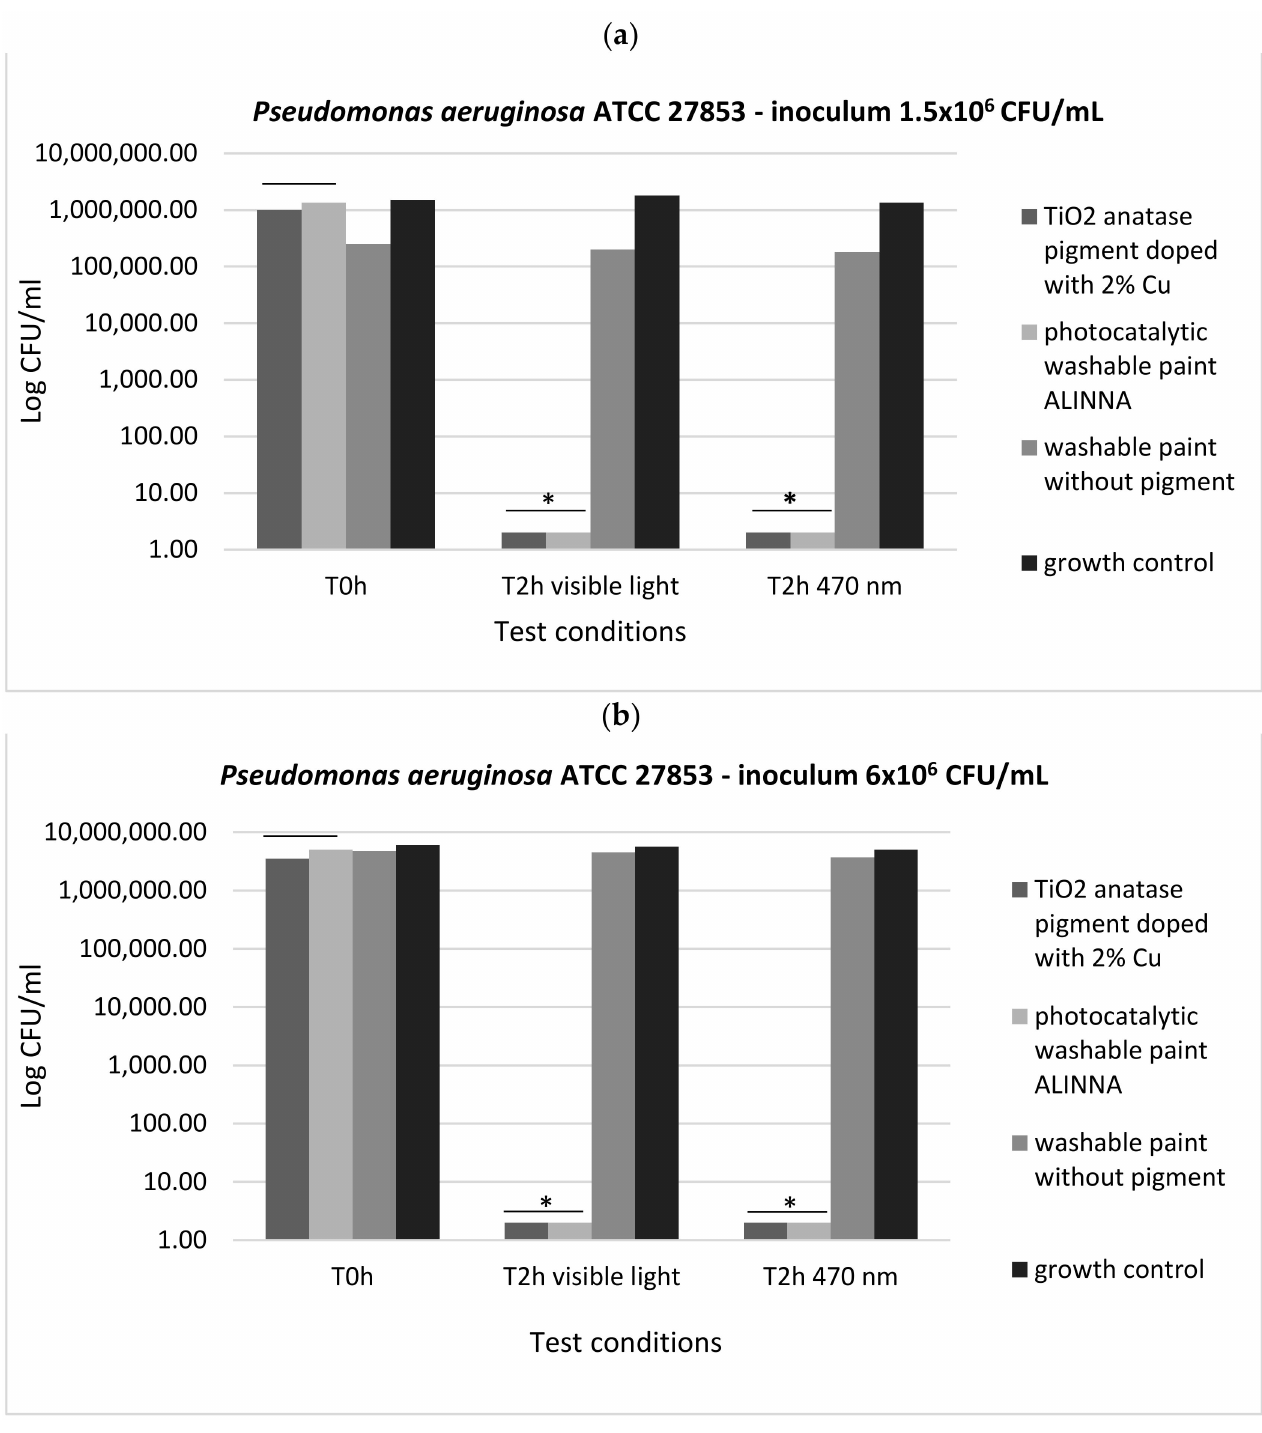
Figure 18. Graphical representation of the log10 values of colony-forming units (CFU)/mL representing the viable cells of P. aeruginosa ATCC 27853 after the 2 h contact with tested products, in two conditions: blue light (470 nm) and visible light; ( a ) 1.5 × 10 6 CFU/mL tested bacterial cell density; ( b ) 6 × 10 6 CFU/mL tested bacterial cell density; * 0.05 ≥ p (T ≤ t) > 0.001 shows significant evidence of inhibitory effect manifested by doped pigment on bacterial growth and